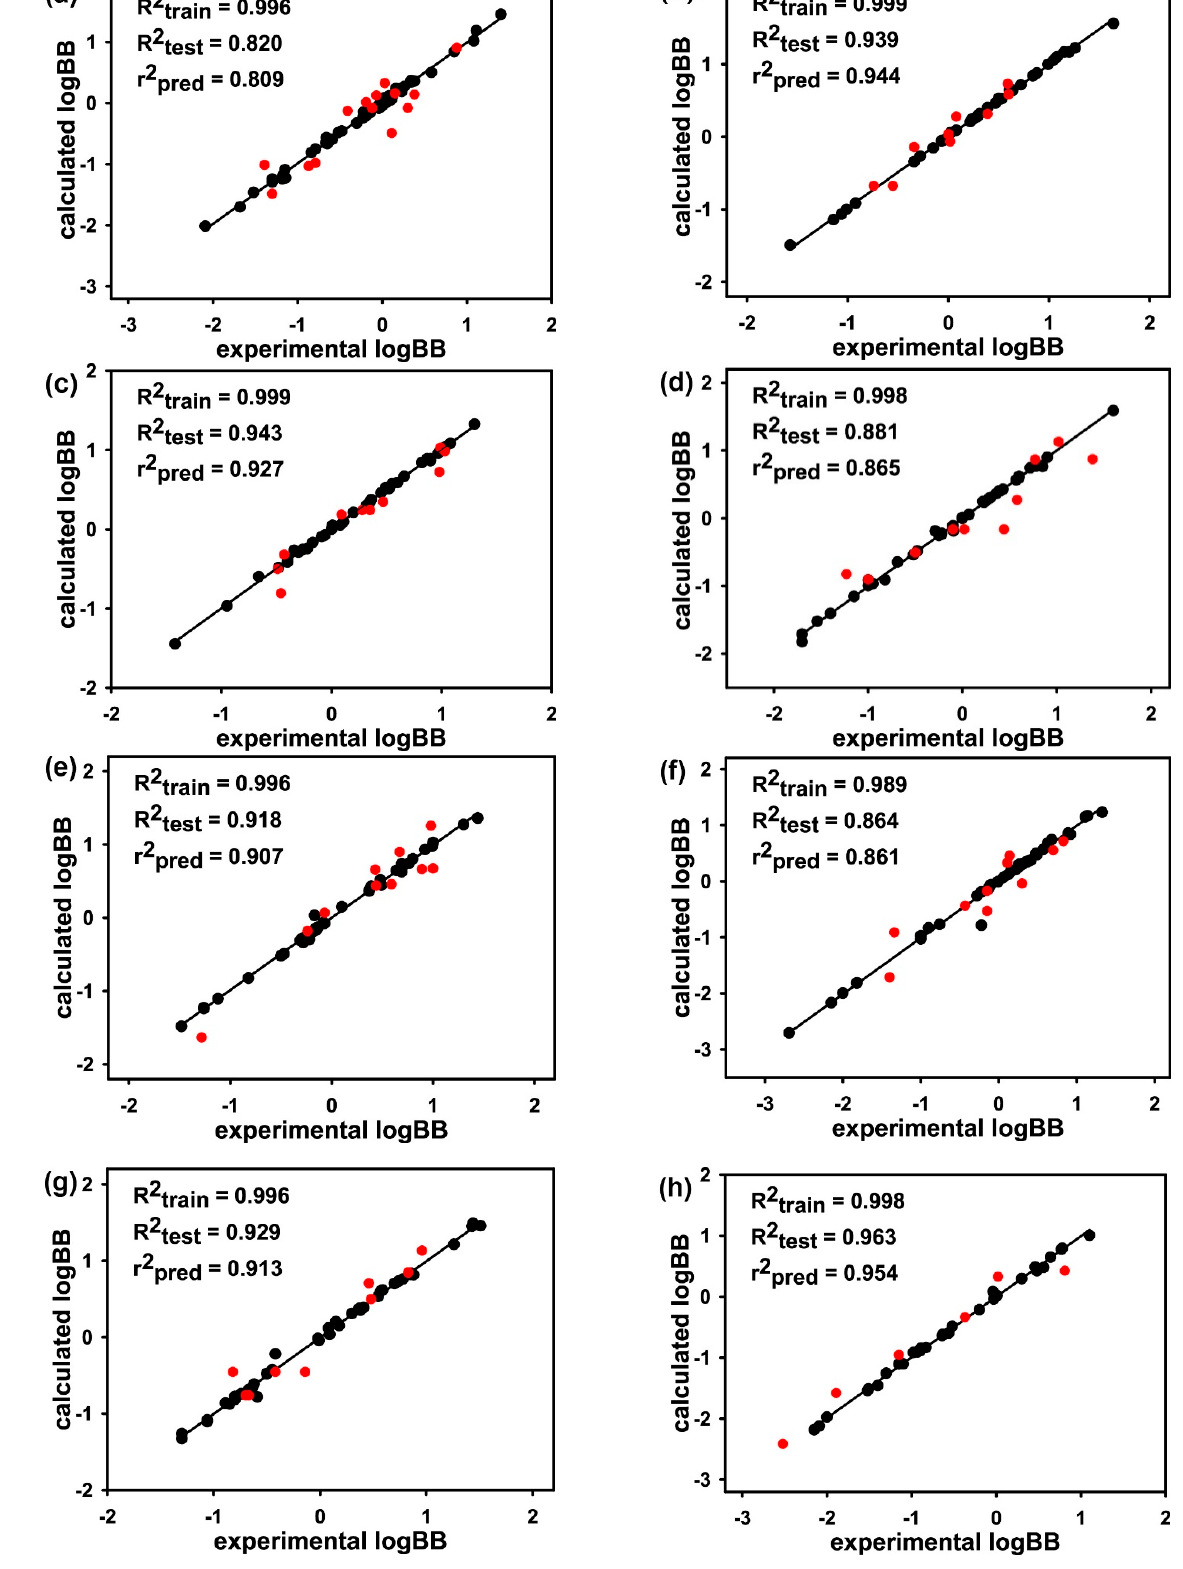
Figure 3. Linear correlation diagram between the experimental and calculated LogBB values for ( a ) Subset 1, ( b ) Subset 2, ( c ) Subset 3, ( d ) Subset 4, ( e ) Subset 5, ( f ) Subset 6, ( g ) Subset 7, and ( h ) Subset 8. Indicated in black and red circles are the molecules in the training and test sets, respectively.